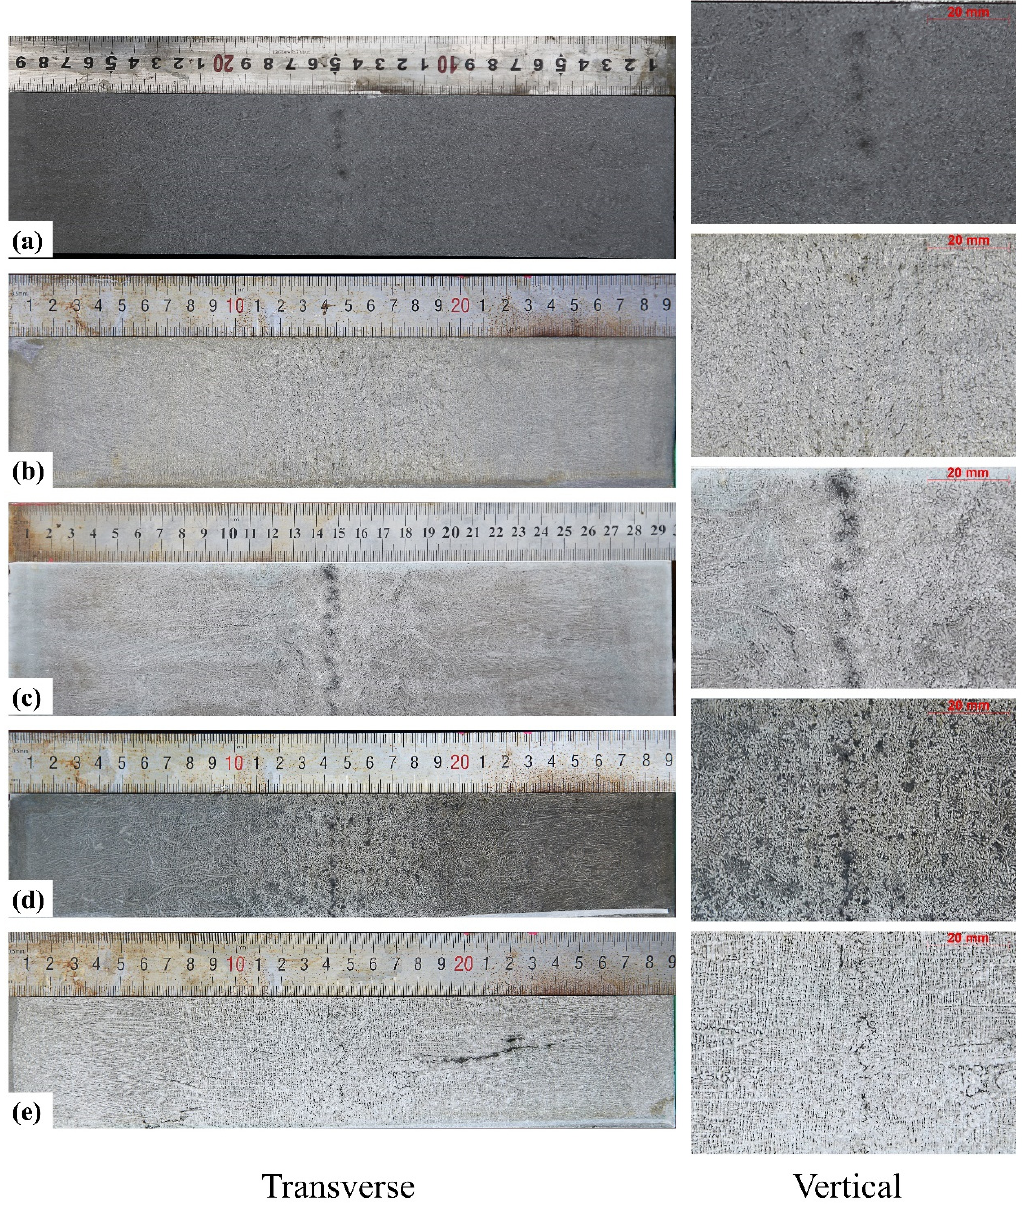
Figure 15. Central segregation rating of 295 × 2270 mm steel slabs: ( a ) S-1; ( b ) S-2; ( c ) S-3; ( d ) S-4; ( e ) S-5.